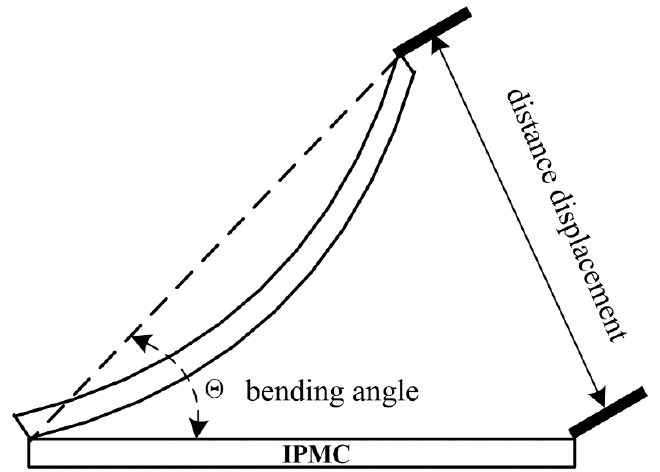
Figure 1. Schematic diagram of the displacement measurement system of the IPMCs.